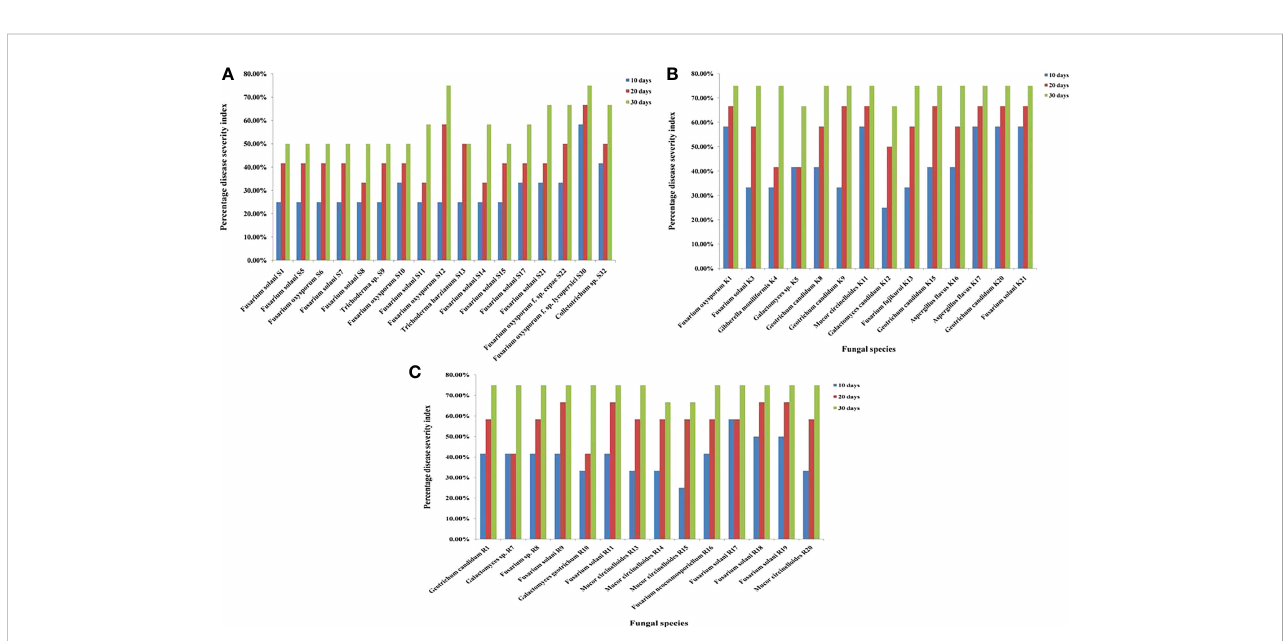
FIGURE 7 (A) Pathogenicity test of fungal species isolated from Srinagar soil on saffron corms at 10, 20, and 30 days post-inoculation (dpi). (B) Pathogenicity test of fungal species isolated from Kishtwar soil on saffron corms at 10, 20 and 30 dpi. (C) Pathogenicity test of fungal species isolated from Ramban soil on saffron corms at 10, 20, and 30